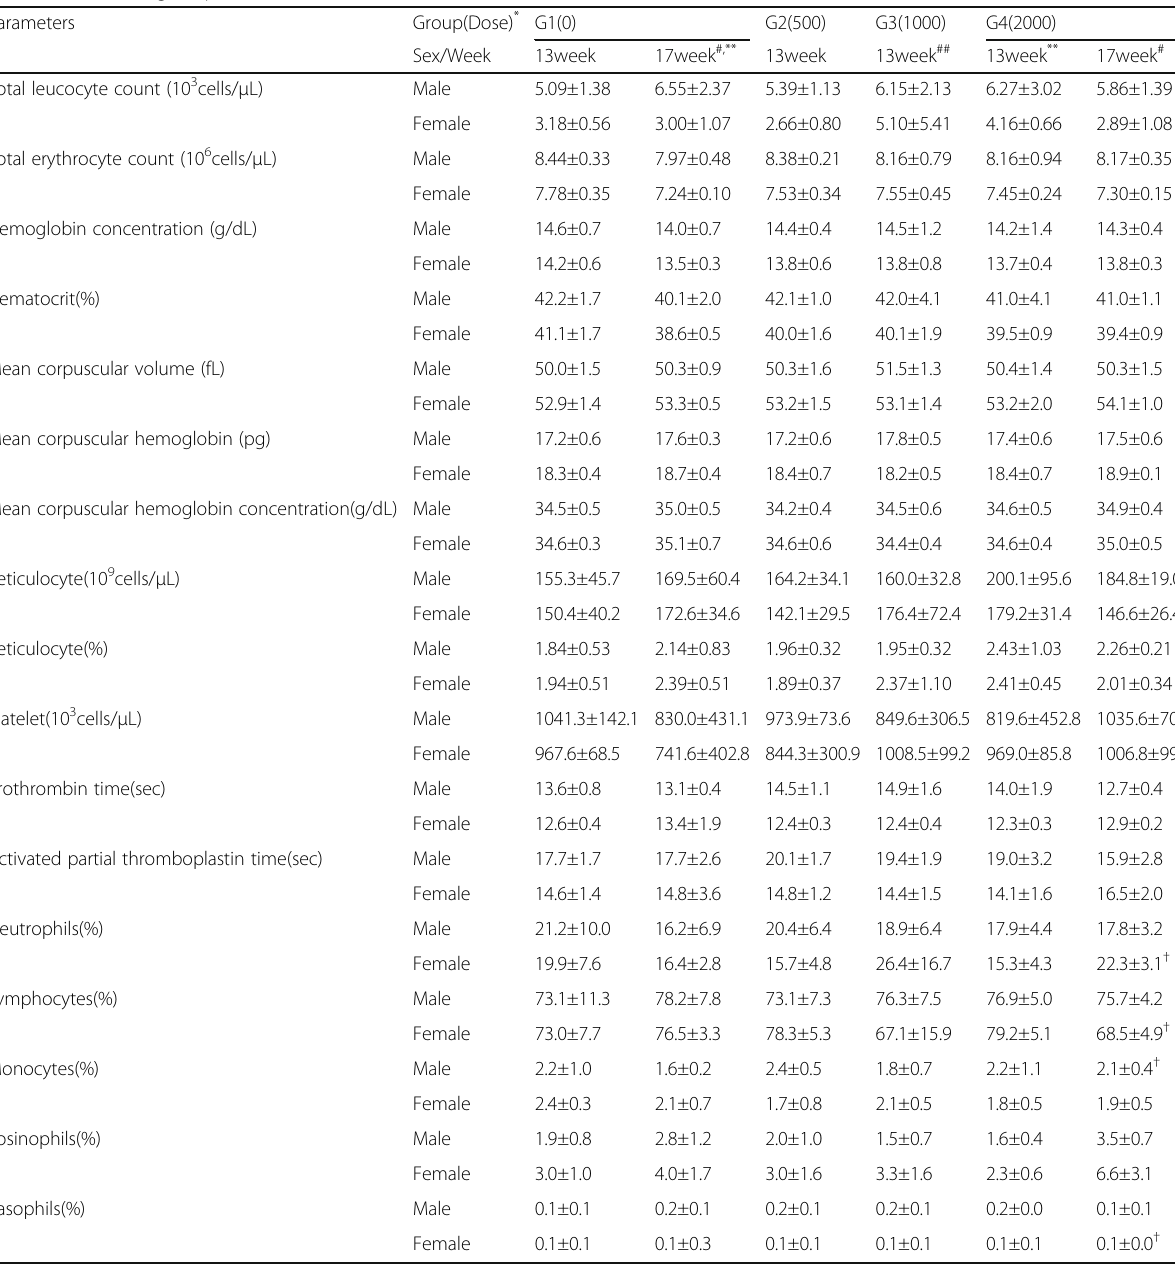
Table 5 Hematological parameters